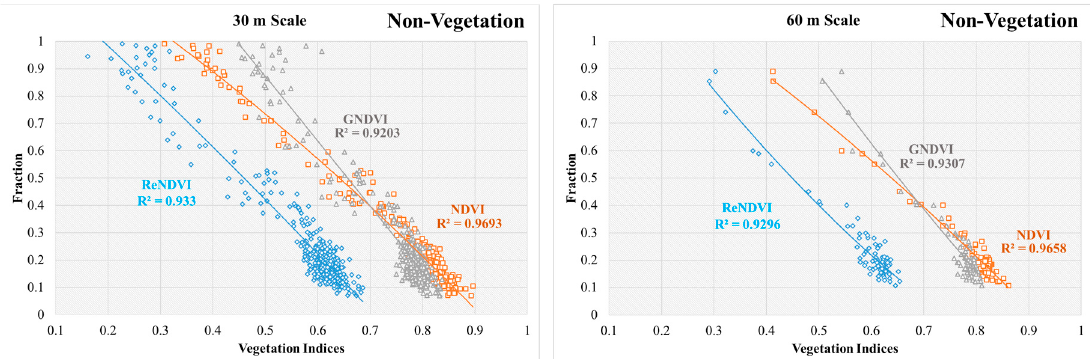
Figure 9. Relationship analysis between the different vegetation indices and fraction of LULC types: Acacia , grass/shrub and non-vegetation (bare soil + water) at different resolution scales.